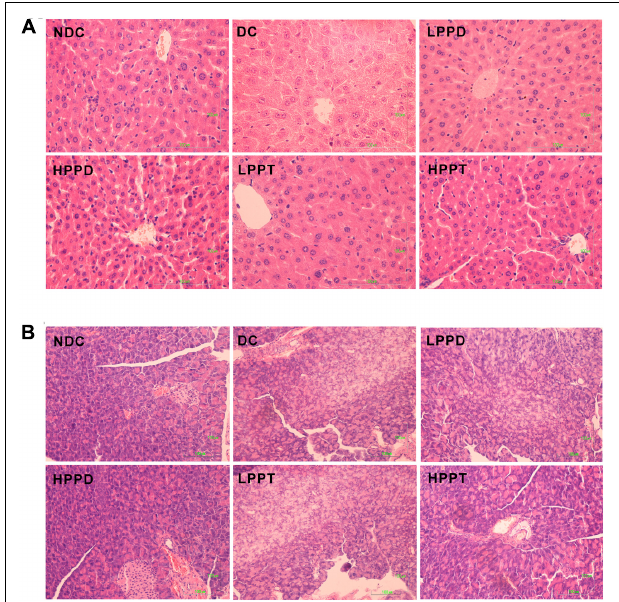
FIGURE 7 | Effects of PPD and PPT on hepatic and panscrea in high-fat diet and STZ-induced diabetic mice. H&E staining of the hepatic